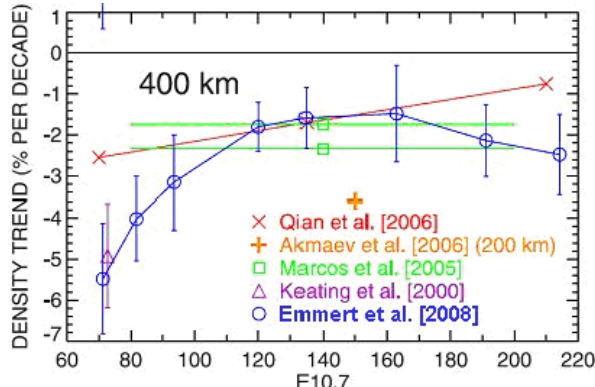
Fig. 1. Summary of various observational (Keating et al., 2000; Marcos et al., 2005; Emmert et al., 2008) and model (Akmaev et al., 2006; Qian et al., 2006) results on long-term trends in the ther- mospheric neutral density. Adopted from Emmert et al.